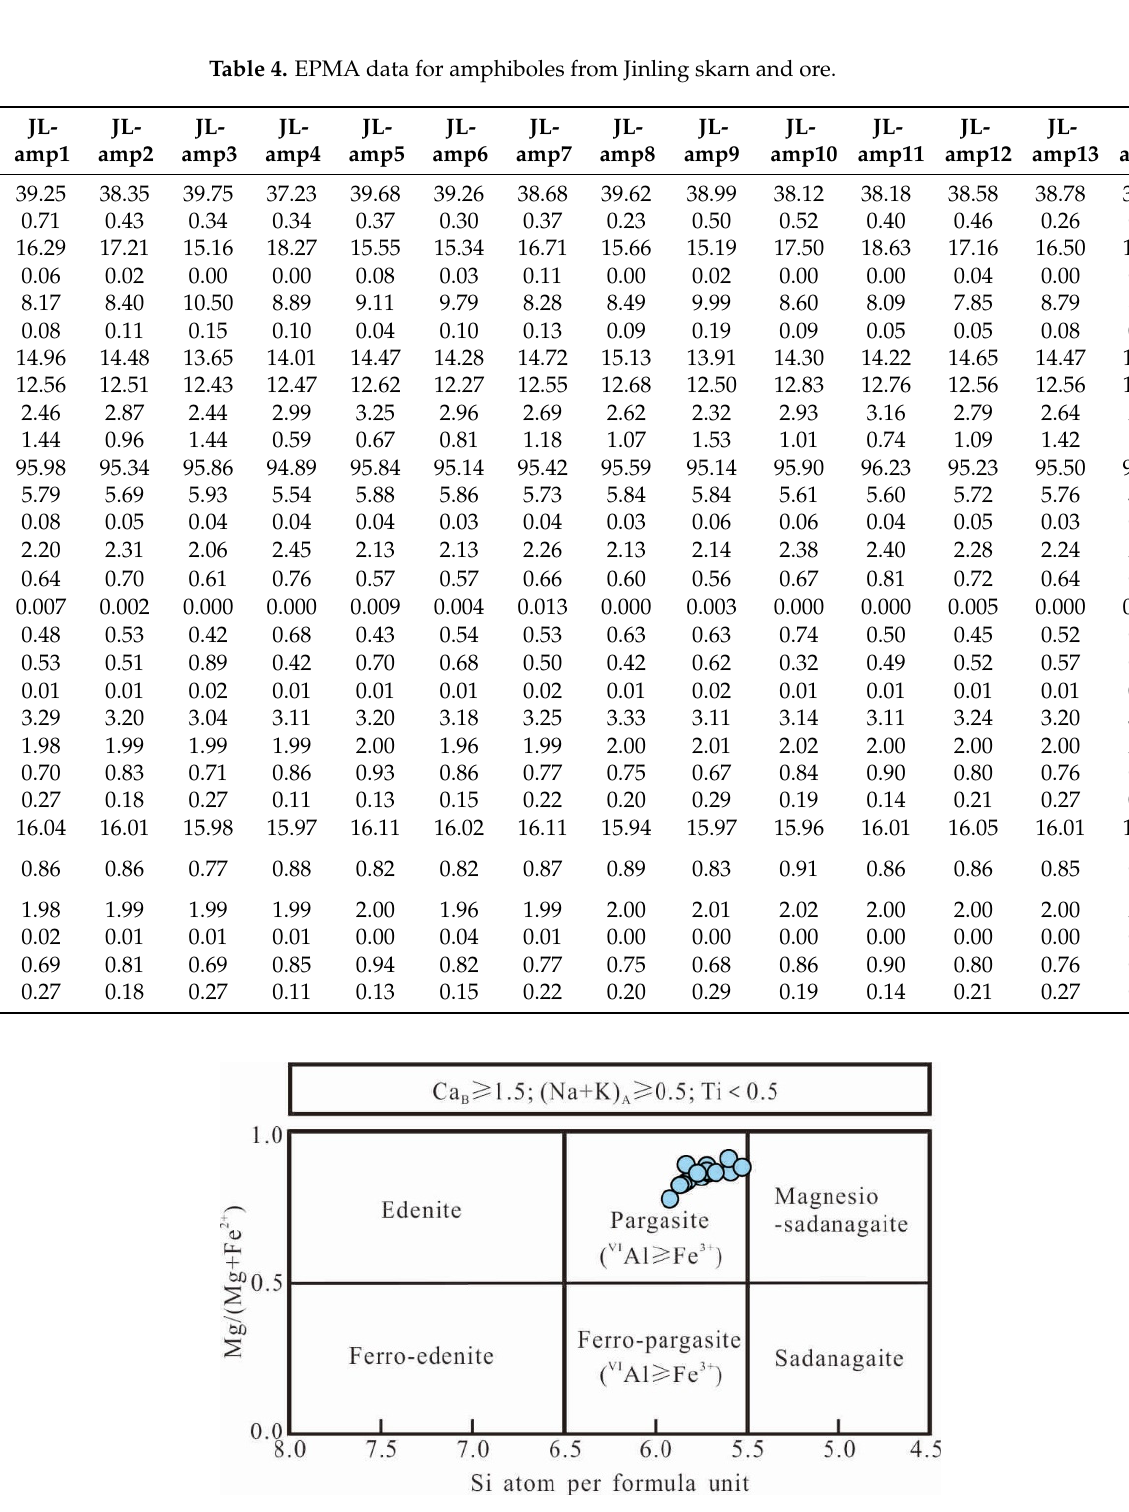
Figure 12. Classification diagram of amphiboles from Jinling skarn and ore.